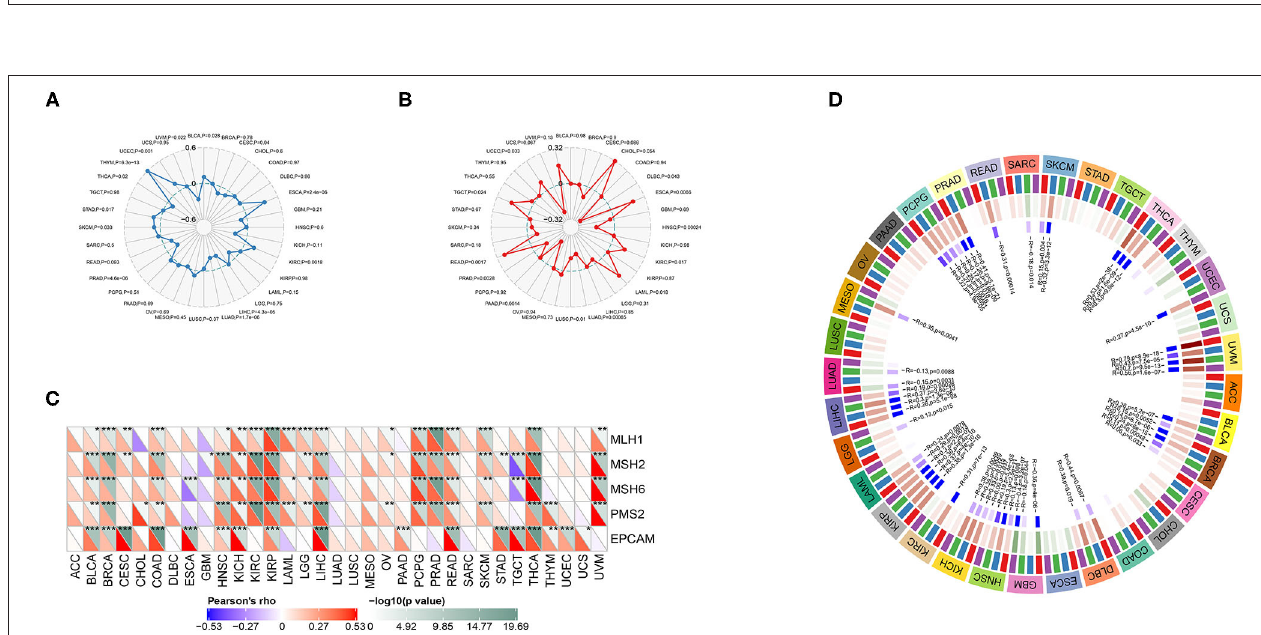
FIGURE 7 | Correlations between ANXA4 expression levels and tumor mutational burden (TMB), microsatellite instability (MSI), mismatch repair (MMR), and DNA methylation. (A) The Rader chart showing correlation between expression levels of ANXA4 and TMB. (B) The Rader chart showing correlation between expression levels of ANXA4 and MSI. (C) Correlations between ANXA4 expression levels and MMR genes ( MLH1 , MSH2 , MSH6 , PMS2 , and EPCAM ). * p < 0.05, ** p < 0.01, *** p < 0.001 (D) Correlations between ANXA4 expression levels and DNA methyltransferases (red: DNMT1, blue: DNMT2, green: DNMT3A, purple: DNMT3B).